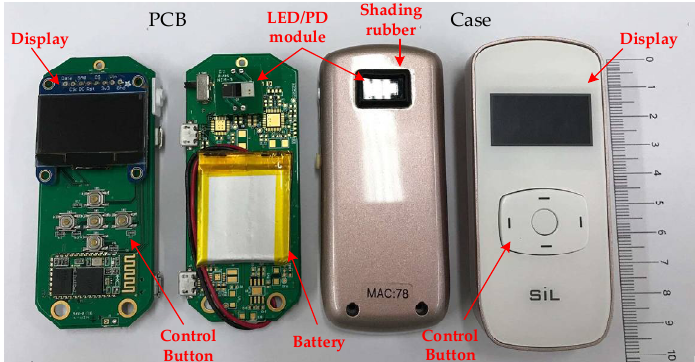
Figure 5. A photo of the proposed portable, wireless, small-sized PPG sensor device for assessing AVF